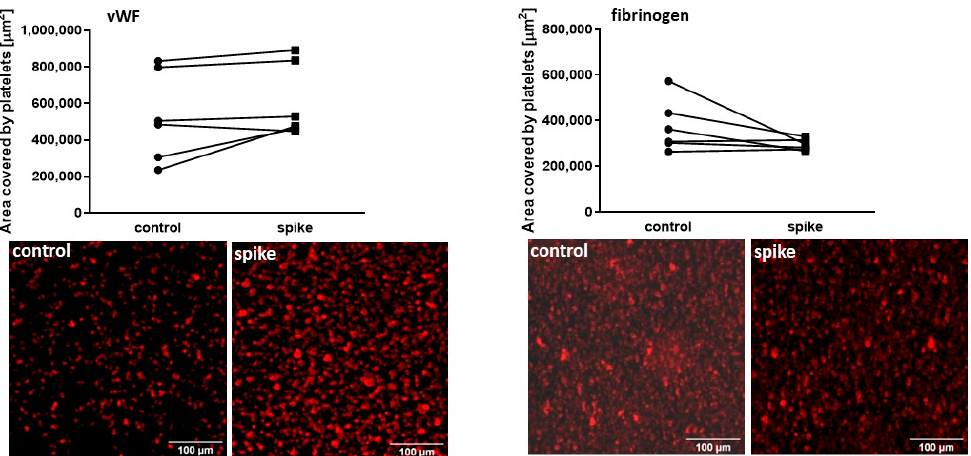
Figure 7. The platelet adhesion under flow conditions to vWF and fibrinogen in the presence of spike protein. No significant differences were observed between spike-treated and control samples (n = 6). Representative images of platelets stained against CD41. Statistical significance of differences between control vs. spike sample was estimated with the Wilcoxon signed-rank test.